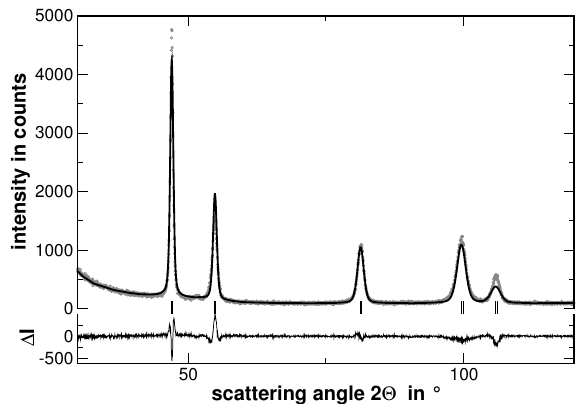
Figure A2. Experimental (points) and calculated (solid line) XRD patterns as well as their difference ∆ I (lower part) and Bragg positions (vertical lines) of homogenized AuCuPdPt.